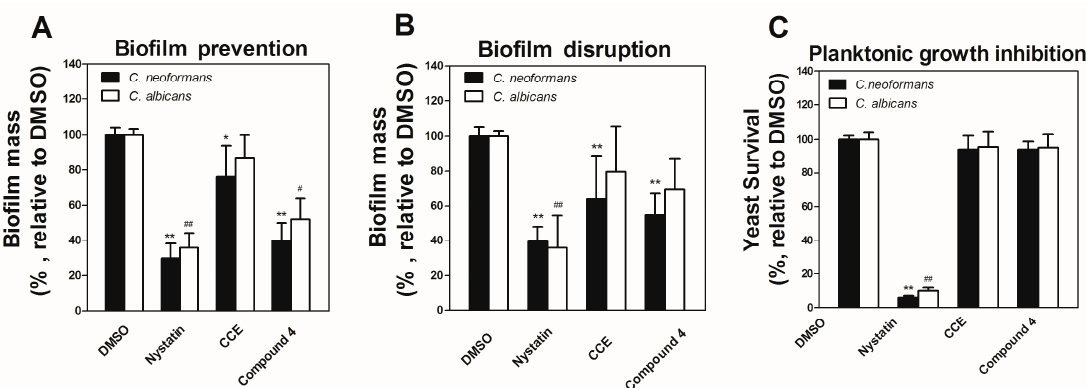
Figure 5. Prevention and disruption of C. neoformans and C. albicans biofilms by compound 4 and the crude Cheerios culture extract (CCE). ( A ) Biofilm prevention compared to DMSO control at 7.8 µ g / mL. ( B ) Disruption of established (24 h) C. neoformans and C. albicans biofilms at 1 mg / mL. ( C ) Planktonic yeasts growth compared to DMSO control at 7.8 µ g / mL. Three independent experiments were conducted. Error bars indicate SEM. (The * / ** and # / ## ) denotes significant di ff erence between DMSO group and compound-treated group ( p < 0.01 and p < 0.05) for C. neoformans (*) and C. albicans (#), respectively.